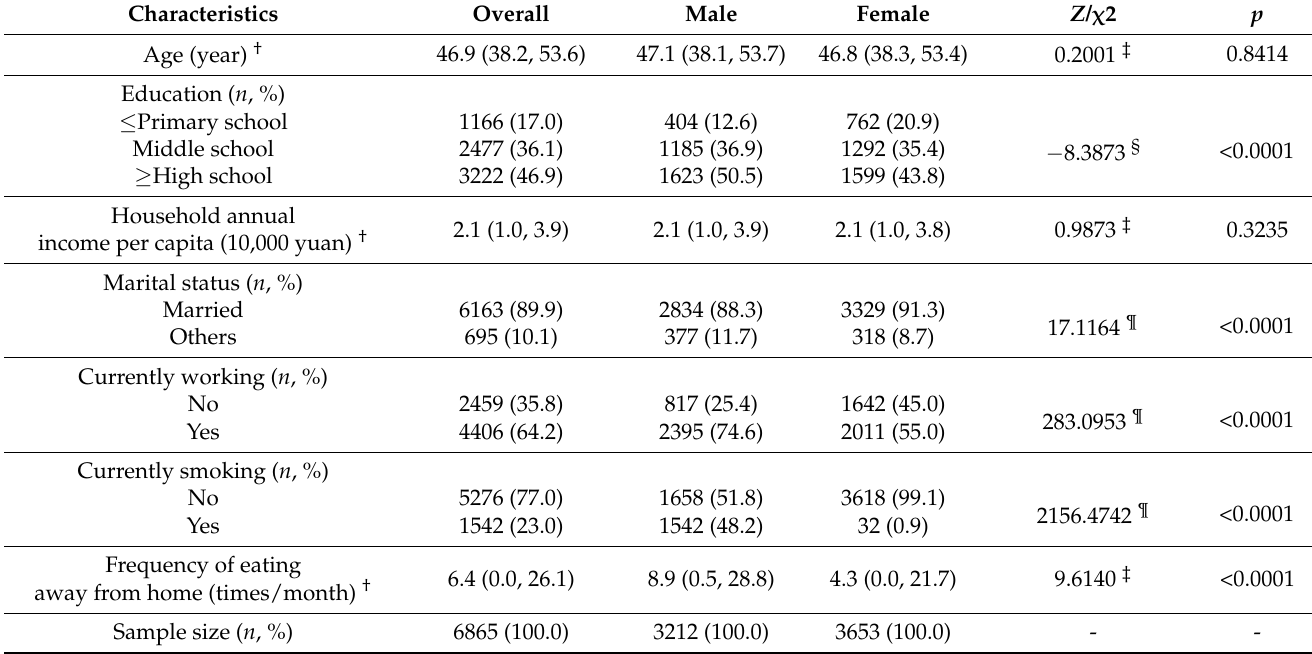
Table 1. Characteristics of the study